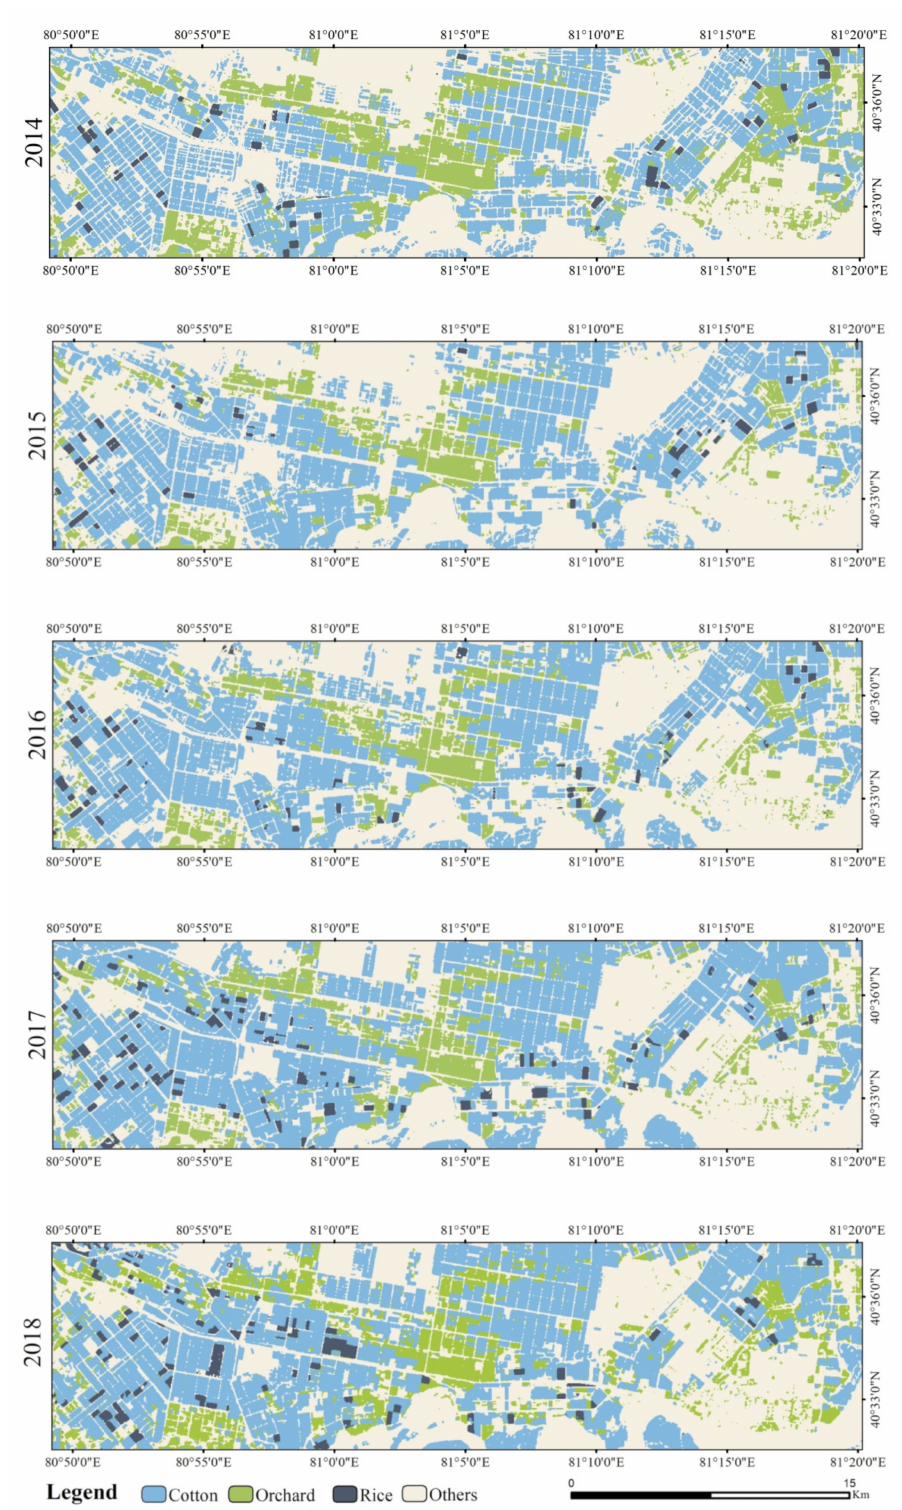
Figure 7. Annual cotton classification maps over the 5-year period from 2014 to